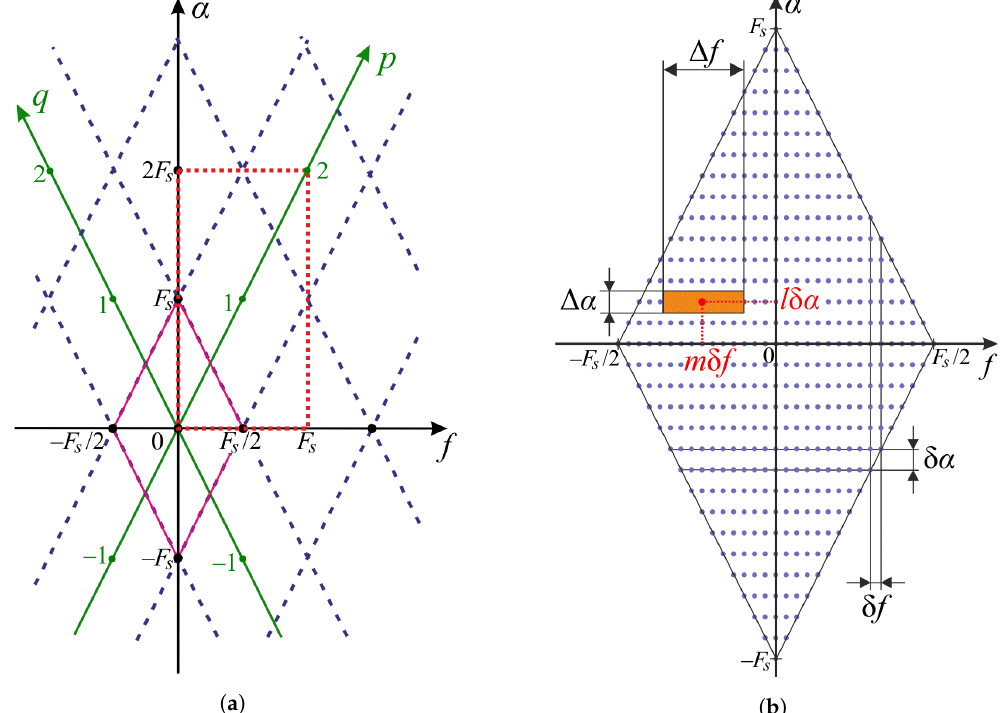
Figure 1. Structure of the “frequency–cyclic frequency” plane: general ( a ) Tiling of the “frequency– cyclic frequency” plane (The principal rhombus centered at the origin is drawn in pink) and detailed ( b ) SCF resolution cell in the bispectral plane and the covering grid consisting of the nodes where SCF is to be evaluated.